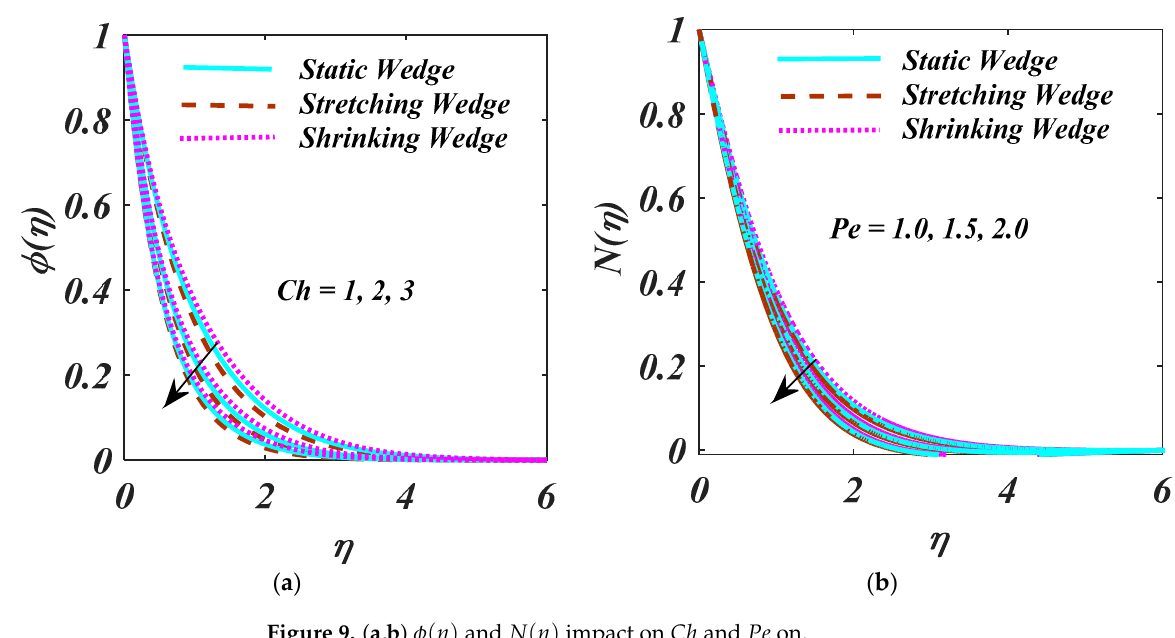
Figure 9. ( a , b ) (cid:2038)(cid:4666)(cid:2015)(cid:4667) and (cid:1840)(cid:4666)(cid:2015)(cid:4667) impact on (cid:1829)(cid:1860) and (cid:1842)(cid:1857) on Figure 9. ( a , b ) φ ( η ) and N ( η ) impact on Ch and Pe on.